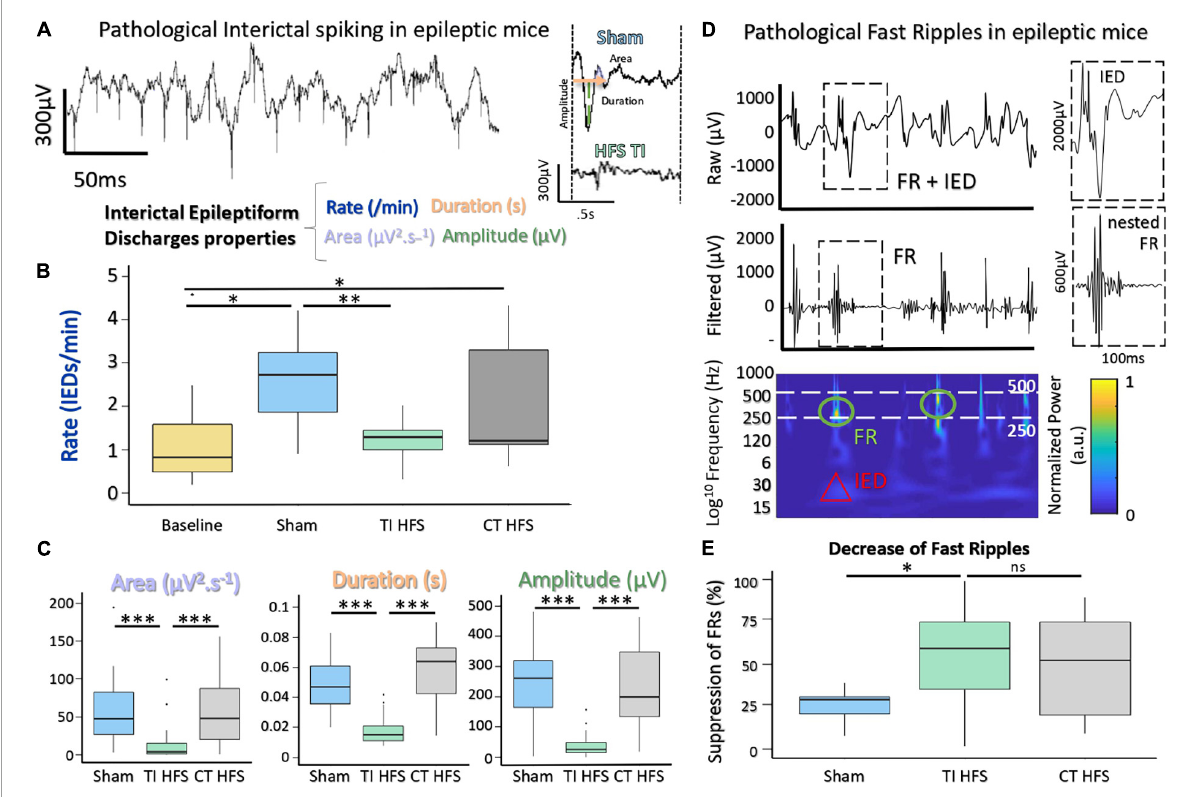
FIGURE3 Suppression of IEDs and FRs with a non-invasive DBS via TI-HFS. (A) Pathological IEDs and their properties: rate, duration amplitude, and area of the wave. (B) Occurrence of pathological IEDs in mice hippocampus. Baseline (yellow) grouped all mice before kindling induction ( ∗ p -value < 0.05). (C) Analysis of IEDs properties. area, duration, and amplitude were calculated for detected IEDs. (D) Raw and filtered [250–500] Hz signal with detected FRs. Time-frequency plot showing activation in FRs band. (E) Pathological FRs occurrence. A ratio for each mouse was calculated to compare pre- and after-treatment. *** p -value < 0.001 and ** p -value <